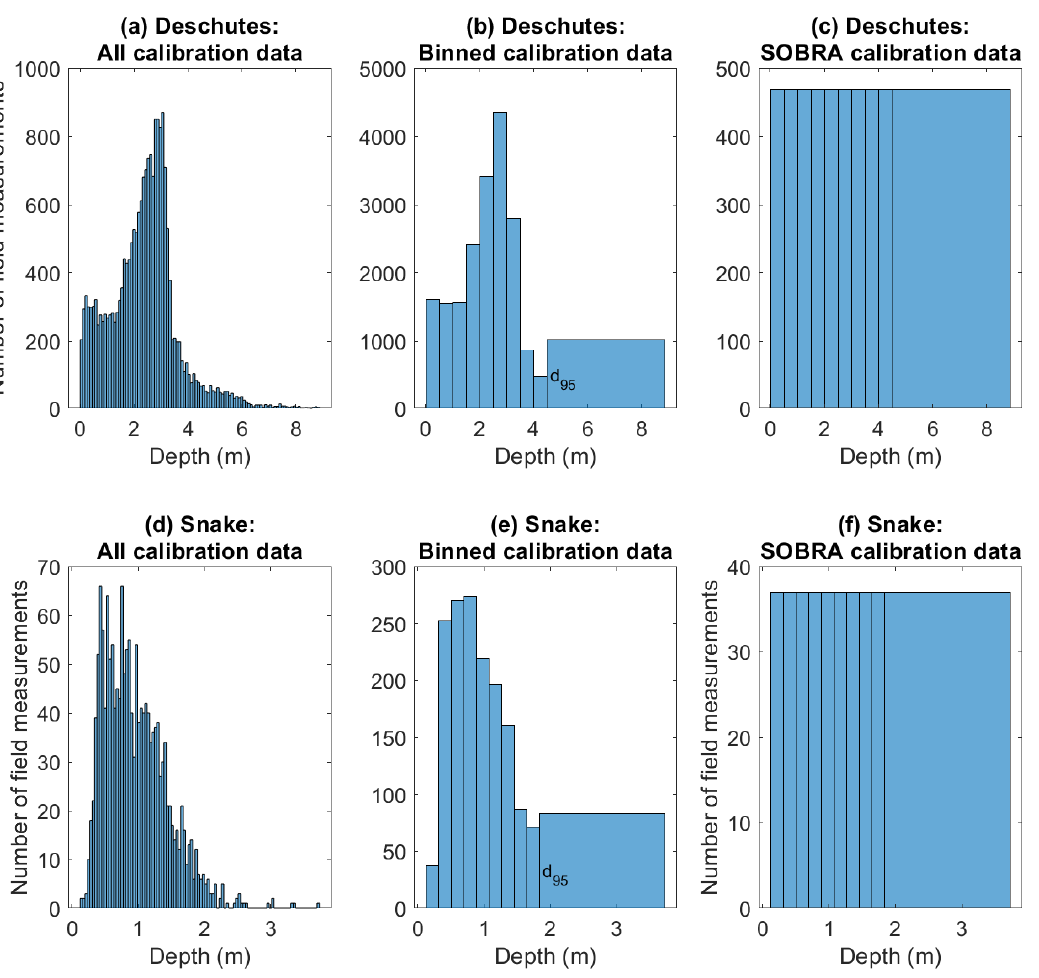
Figure 3. Histograms of the original field data set, the binned data set, and the final calibration data set used for Stratified Optimal Band Ratio Analysis (SOBRA) for each study site. The binned histograms used for SOBRA consist of 10 bins, each with an equal number of observations sampled at random from each depth bin. The deepest bin extends from the 95th percentile of the original depth distribution to the maximum depth in the data